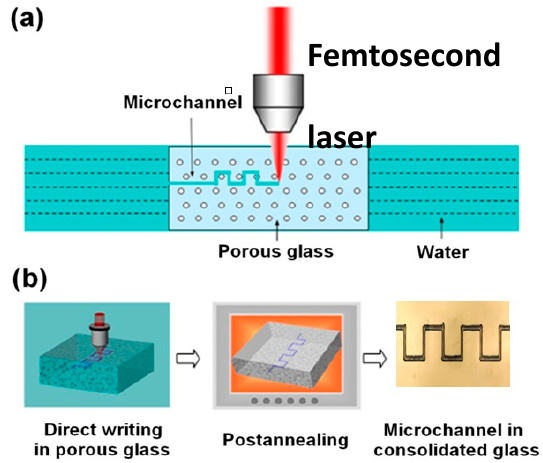
Figure 1. ( a ) Schematic of experimental setup; and ( b ) flow diagram for the fabrication process.